Question: In a single sentence, describe what this figure presents.
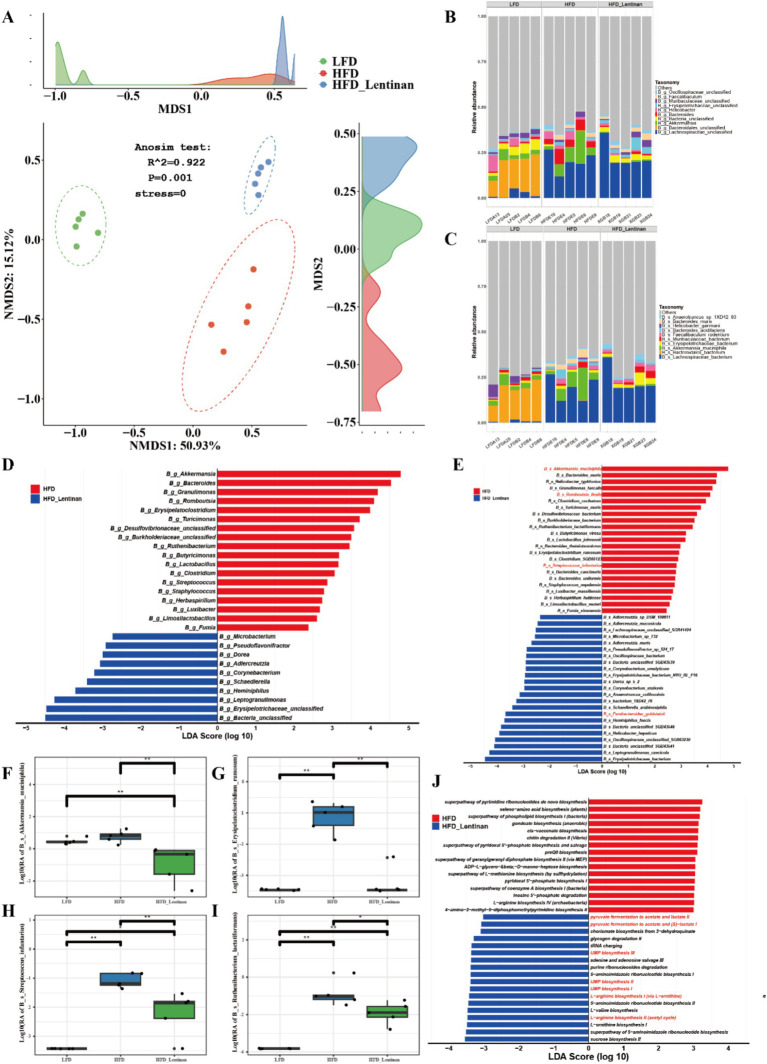
Answer: Lentinan altered the structure and function of gut microbiota in HFD mice. (A) NMDS analysis based on Jaccard distance for microbial community composition. (B) Relative abundance of top 10 genera. (C) Relative abundance of top 10 species. (D) LEfSe analysis at the genus level. (E) LEfSe analysis at the species level. (F) Comparison of Akkermansia muciniphila abundance among groups. (G) Comparison of Erysipelatoclostridium ramosum abundance. (H) Comparison of Streptococcus infantarius abundance. (I) Comparison of Ruthenibacterium lactatiformans abundance. (J) LEfSe analysis of gut microbiota gene metabolic pathways. Statistical analysis was performed using one-way ANOVA followed by the Dunnett’s post hoc test. * p ≤ 0.05; ** p ≤ 0.01.